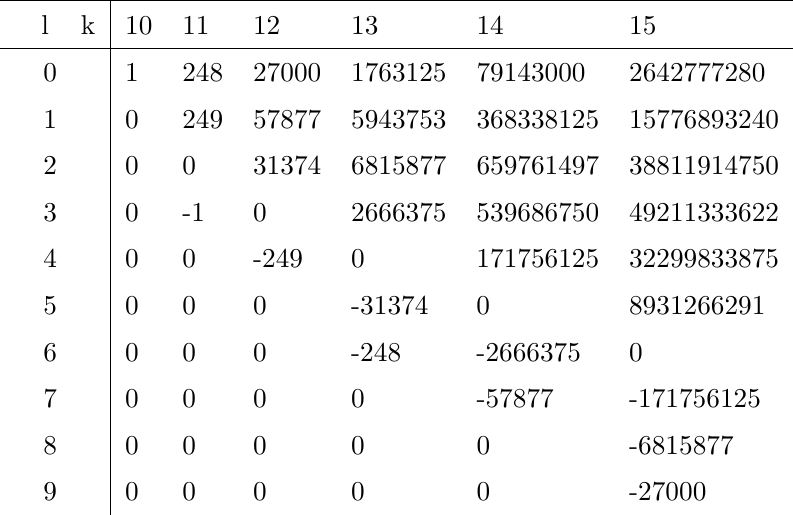
Table 5 . Series expansion coe(cid:14)cients b E 8